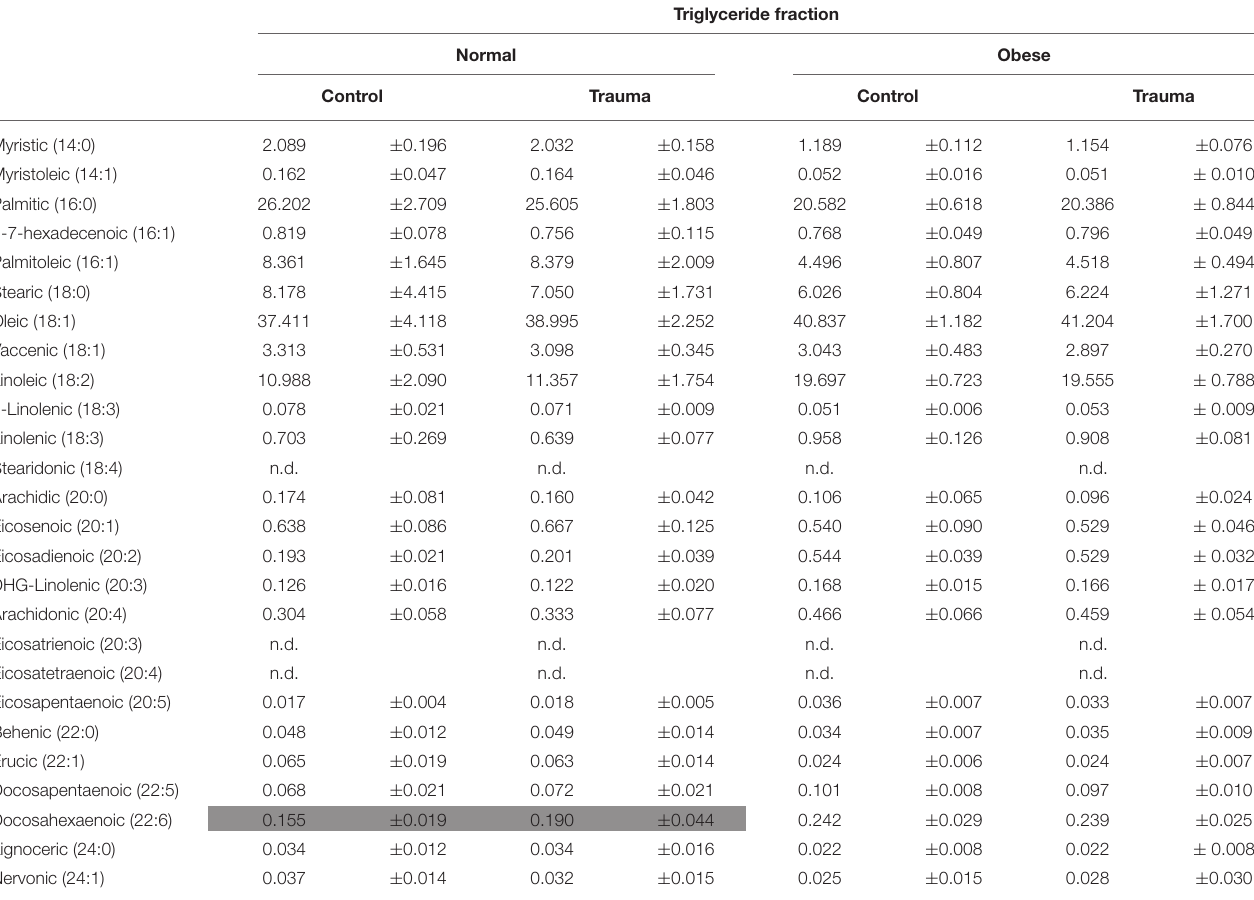
TABLE 5 | FA-composition of triglyceride fraction in muscle tissue. Triglyceride fraction Normal Obese Control Trauma Control